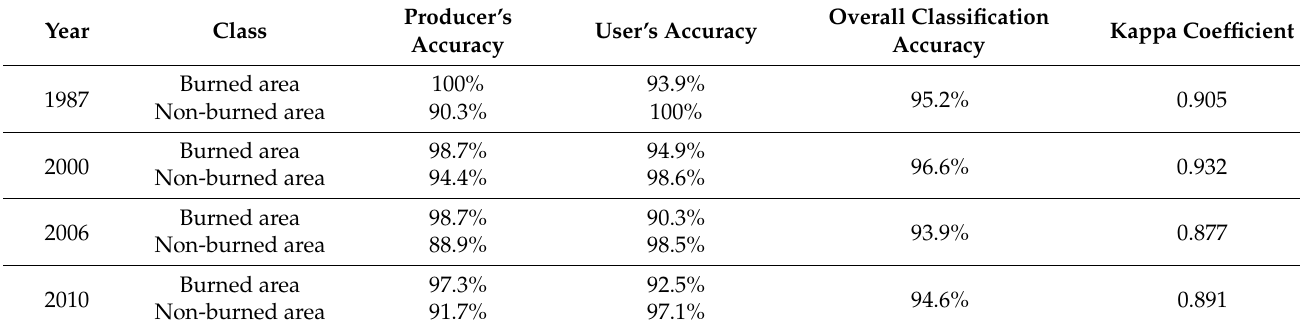
Table 4. Error matrix for the classification of the burned areas in 1987, 2000, 2006, and 2010.